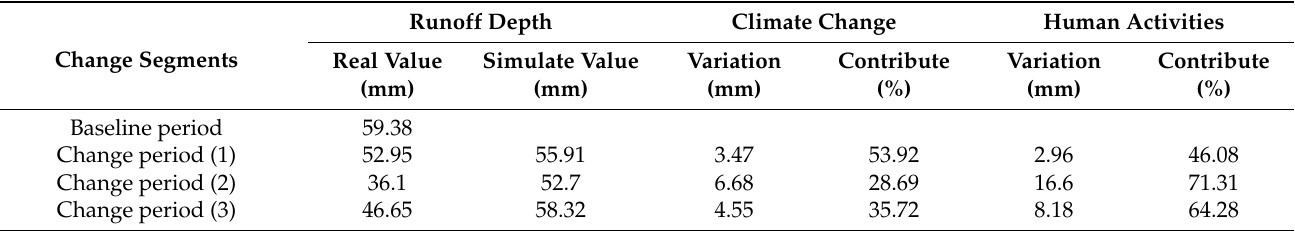
Table 7. Contribution rate of runoff change by the runoff reduction